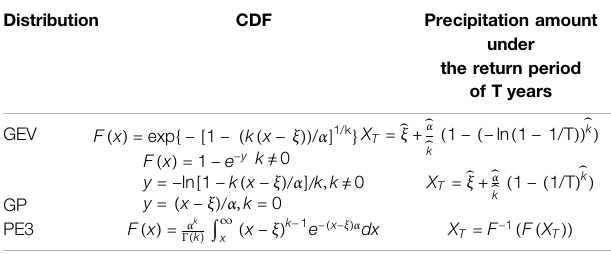
under the return period of T years of GEV, GP and PE3 distributions. Distribution CDF Precipitation amount